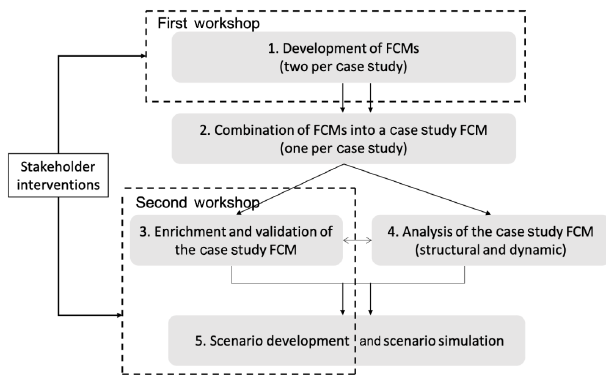
Figure 2. Methodological steps in the